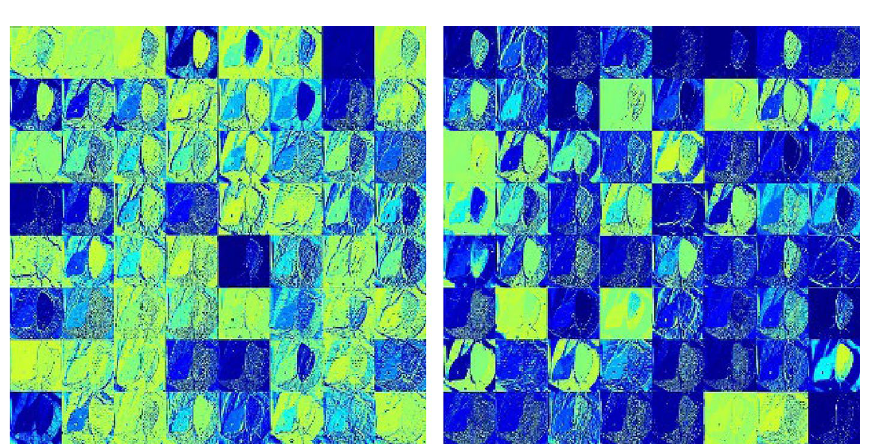
Figure 14. Feature visualization results (Third layer and fourth layer). Note : The brighter the pixel, the higher the